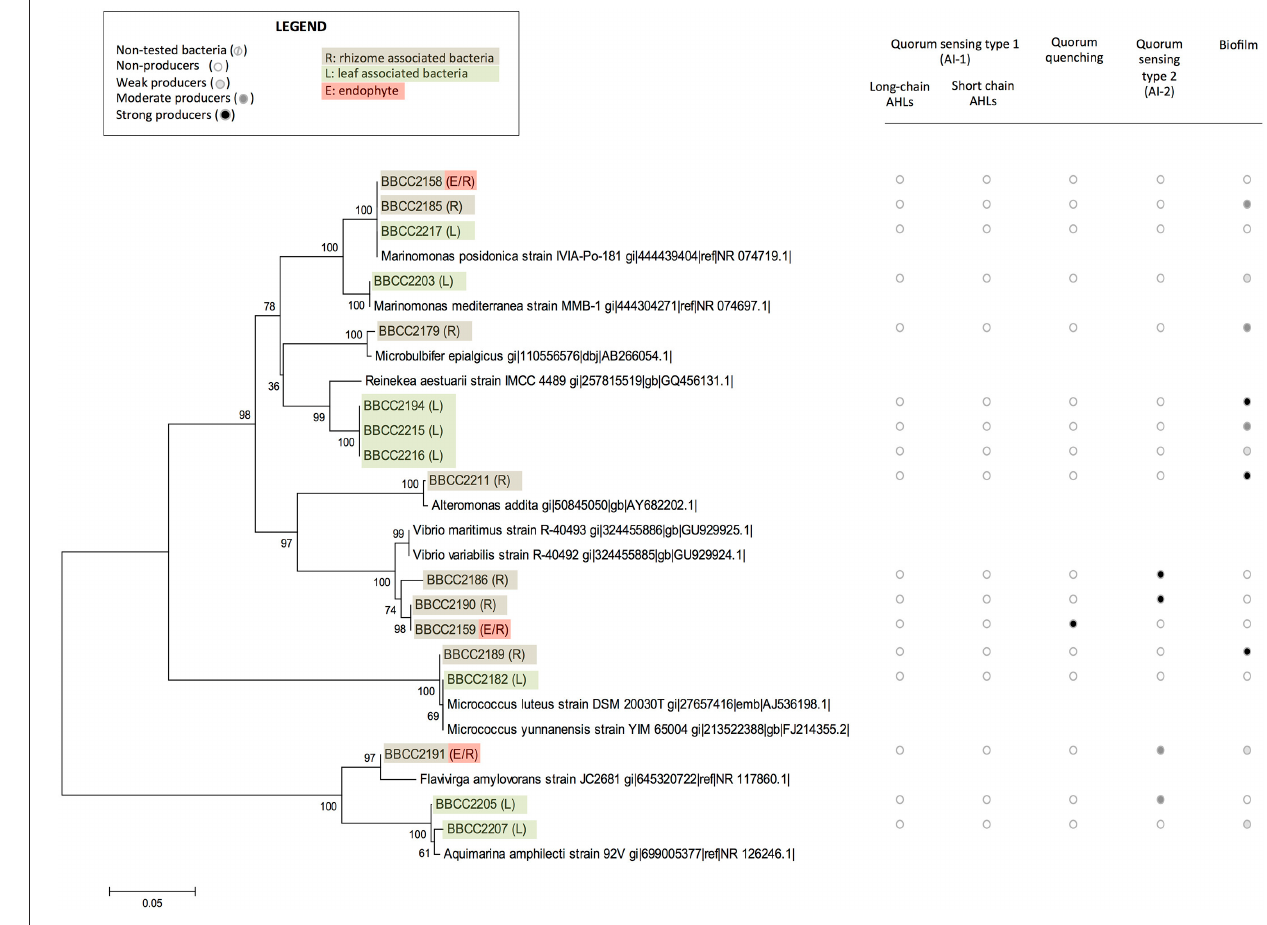
FIGURE 2 | The phylogenetic affiliations of sequences of non- Alphaproteobacteria -related strains associated with Posidonia oceanica and their abilities to express quorum sensing, quorum quenching or biofilm formation. The values at each node represent the bootstrap values generated using MEGA 6.0 [Neighbor-joining method with bootstrap (1,000 replications)]. Non-tested bacteria ( ), non-producers ( ), weak producers ( ), moderate producers ( ), and strong producers ( ) R: rhizome associated bacteria, L: leaf associated bacteria, and E: